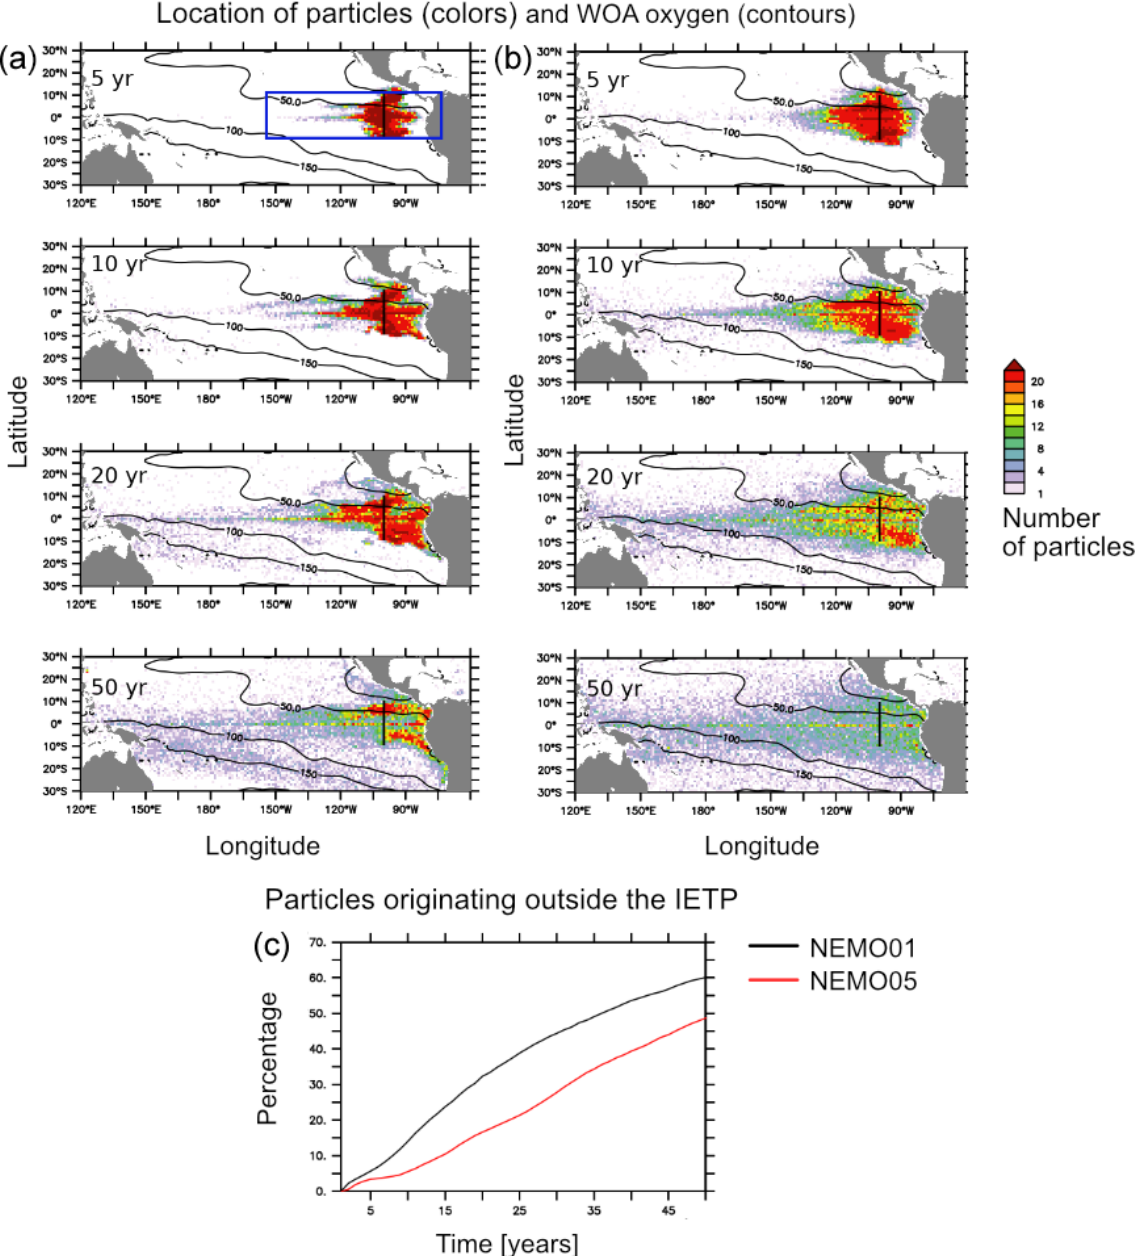
Figure 7. Density (number of particles in a 1 ◦ × 1 ◦ box) distribution of the location of released Lagrangian particles – backward integration after 5 (top row), 10 (second row), 20 (third row), and 50 (bottom row) years – in (a) NEMO05 and (b) NEMO01. The release location is identified in bold and is located at 100 ◦ W, 10 ◦ N–10 ◦ S, 500–1500m of depth (black line). The number of particles has been integrated vertically. The observed mean (500–1500m) oxygen levels (WOA) are displayed as contours. The blue contour represents the Intermediate Eastern Tropical Pacific (IETP) basin. (c) Percentage of particles originating outside the Intermediate Eastern Tropical Pacific (IETP) basin (160 ◦ W, 10 ◦ N–10 ◦ S, 500–1500m) in NEMO05 (red) and NEMO01 (black) over time